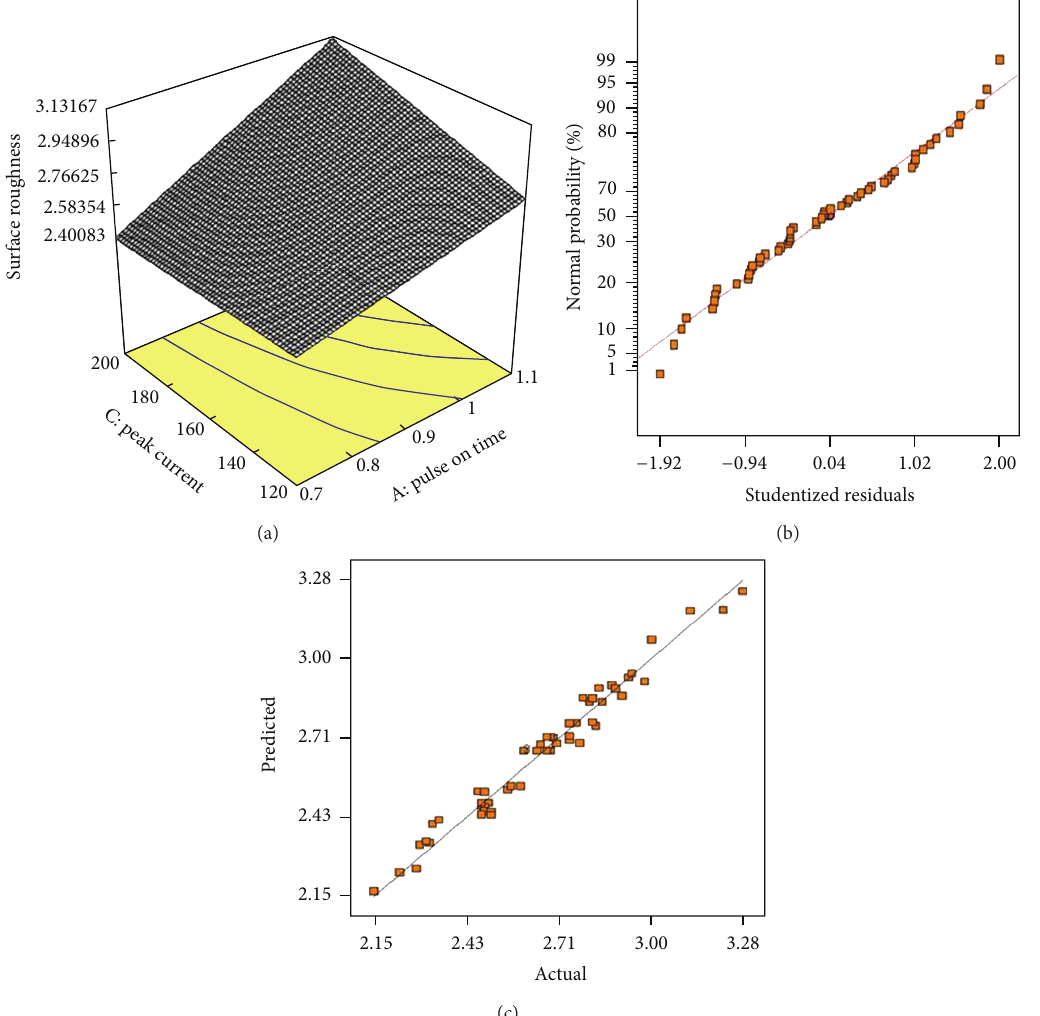
Figure 4: Response surface plot for surface roughness: (a) interaction plot between pulse on time and peak current, (b) normal probability plot residuals, (c) actual versus predicted